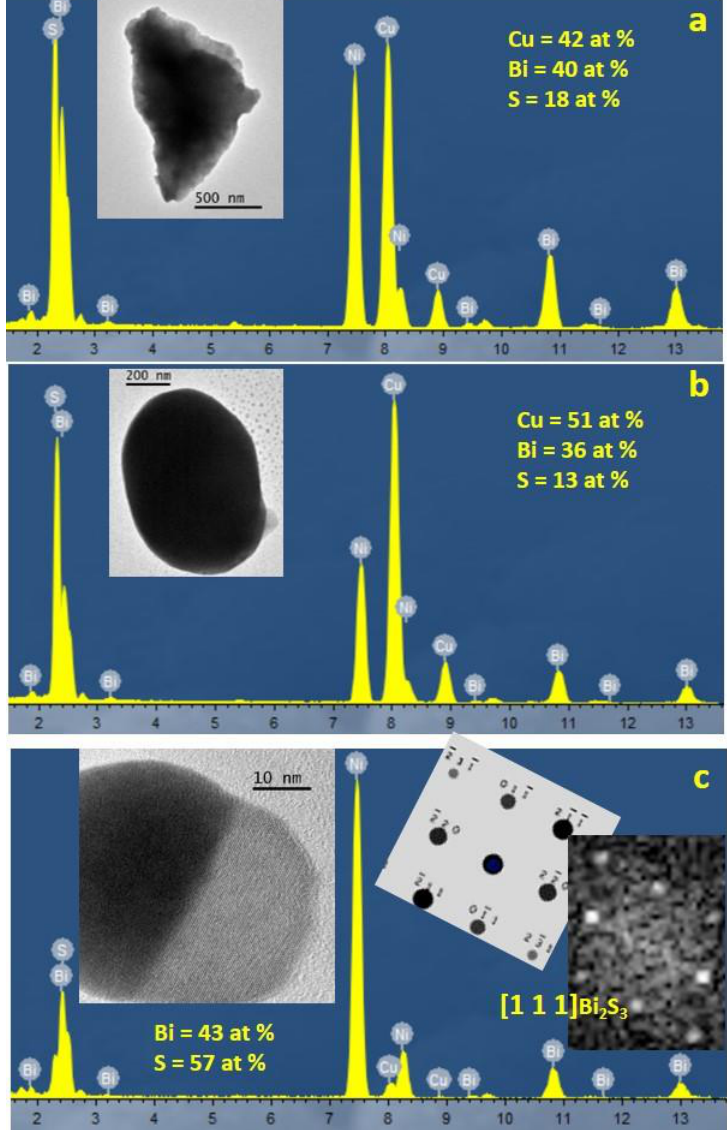
Figure 4. EDX spectra with inset of TEM/HRTEM images of Cu 3 BiS 3 sample before irradiation ( a ) and after irradiation ( b – c ).